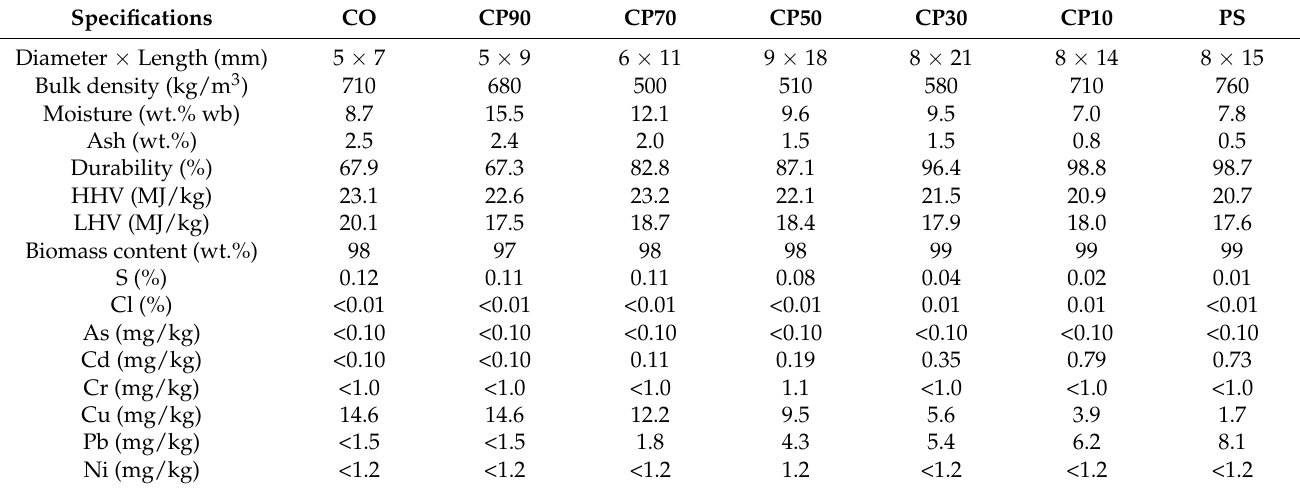
Table 5. Fuel properties of various pellets.